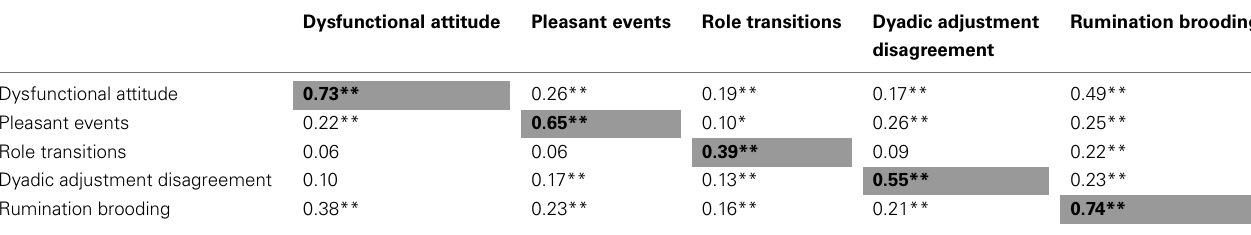
Table 2 | Cross-sectional and longitudinal intercorrelations among the psychosocial vulnerabilities and rumination.